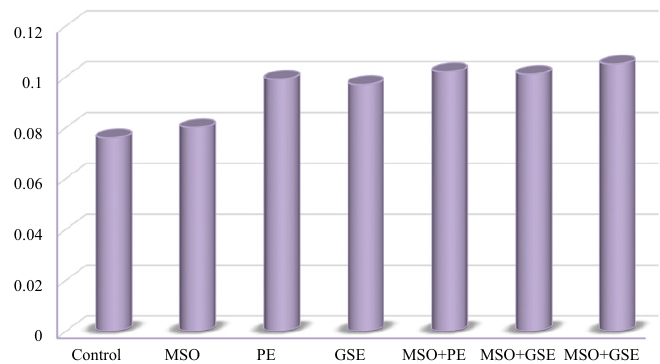
Fig. 1. Thickness properties of nanochitosan film incorporated with M. spicata essential oil (MSO), pomegranate peel extract (PE) and grape seed extract (GSE)